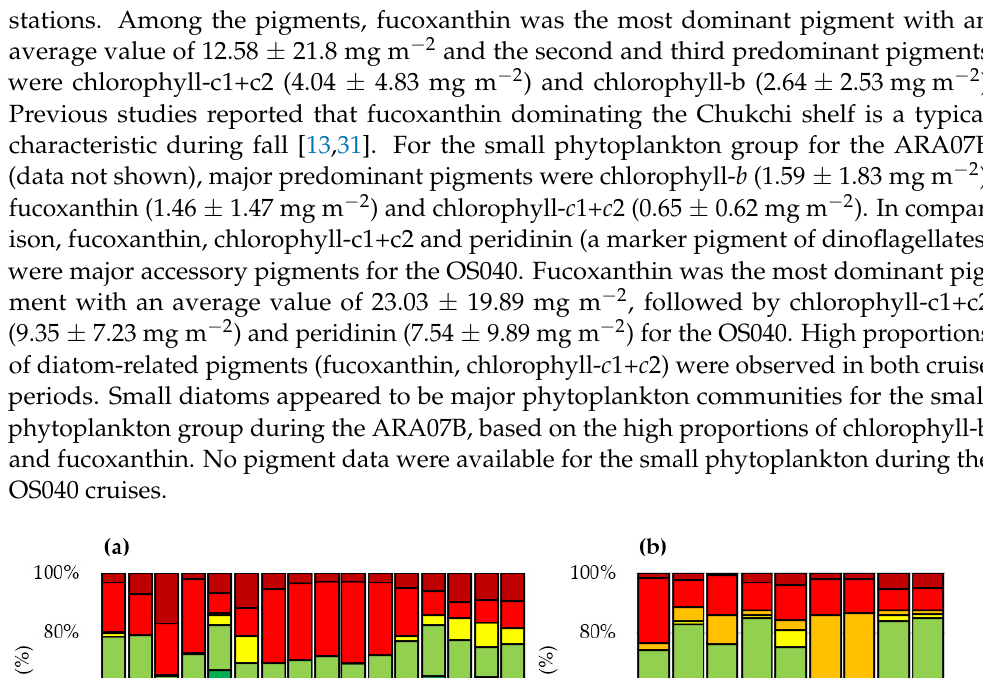
Figure 6. Phytoplankton community compositions of ( a ) ARA07B and ( b ) OS040. 3.4. Primary Production Contribution of Small Phytoplankton and Their Ecological Roles The daily primary productivities of total phytoplankton which were integrated over the euphotic zone at each station were 33.9–811.8 mg C m − 2 d − 1 (mean ± SD = 142.6 ± 205.7 mg C m − 2 d − 1 ) for the ARA07B and 202.1–3100.1 mg C m − 2 d − 1 (mean ± SD = 942.1 ± 969.9 mg C m − 2 d − 1 ) for the OS040 (Figure 7). In comparison, the daily primary productivities of small phytoplankton ranged from 4.9 to 227.7 (mean ± SD = 42.3 ± 53.1 mg C m − 2 d − 1 ) and 56.1 to 322.2 mg C m − 2 d − 1 (mean ± SD = 152.8 ± 85.2 mg C m − 2 d − 1 ) for the ARA07B and the